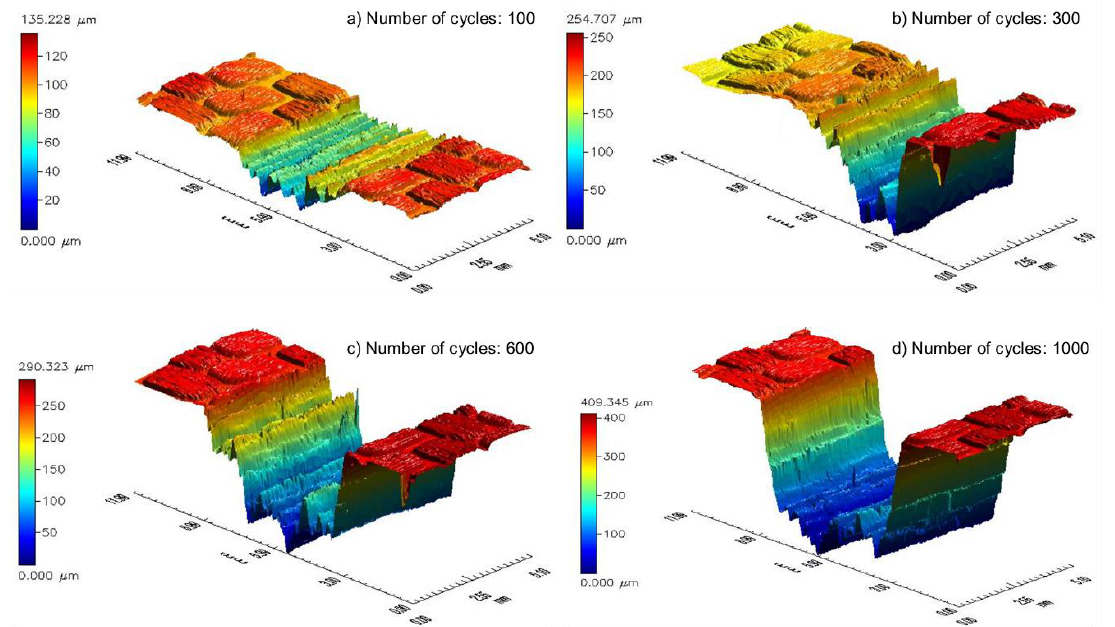
Figure 7. Exemplary maps of the surface sample (six months of weathering) after ( a ) 100, ( b ) 300, ( c ) 600, and ( d ) 1000 cycles of wet abrasive wear.